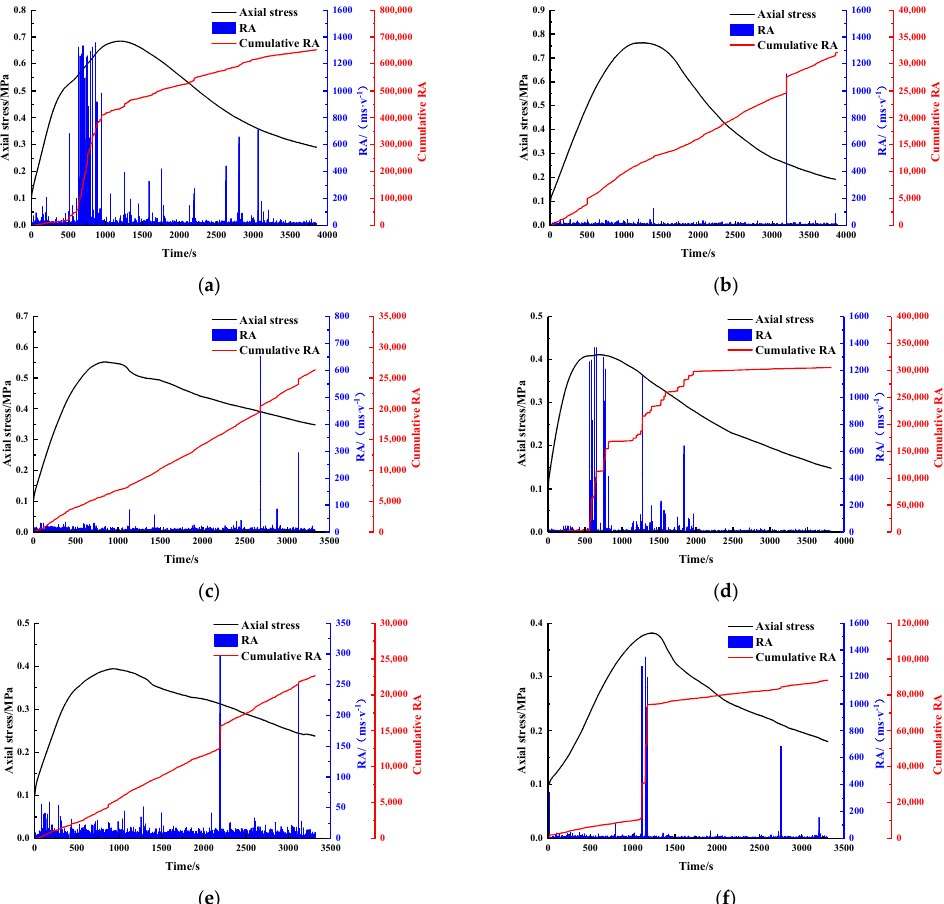
Figure 8. Acoustic emission (AE) characteristics of CGFB samples. ( a ) A-1; ( b ) B-2; ( c ) C-2; ( d ) D-3; ( e ) E-3; ( f ) F-3. With the increase of the amount of kaolin instead of cement, the fluctuation of the Ra value of CGFB samples increases, and the difference of its cumulative Ra value decreases, which increases the number of tensile cracks in CGFB samples. This shows that a decrease in the cement content leads to a decrease in the degree of internal bonding. During the compression process, a large amount of elastic energy is stored in the gangue particles. With the increase in sample deformation, energy is released near the gangue particles and causes chain failure of the surrounding structure, resulting in tensile failure accompanied by local shear failure of the sample. 3.3. Microstructure Characteristics The microstructure and morphology of the fracture surface of CGFB samples are an- alyzed using SEM and are shown in Figure 9. It can be seen that the microstructure and morphology of fracture surfaces of different CGFB samples are different. Because of the disappearance of the coating layer on the surface of CGFB samples, the rate of hydration reaction increases, and a large amount of flocculated calcium-silicate-hydrate (C-S-H) gel